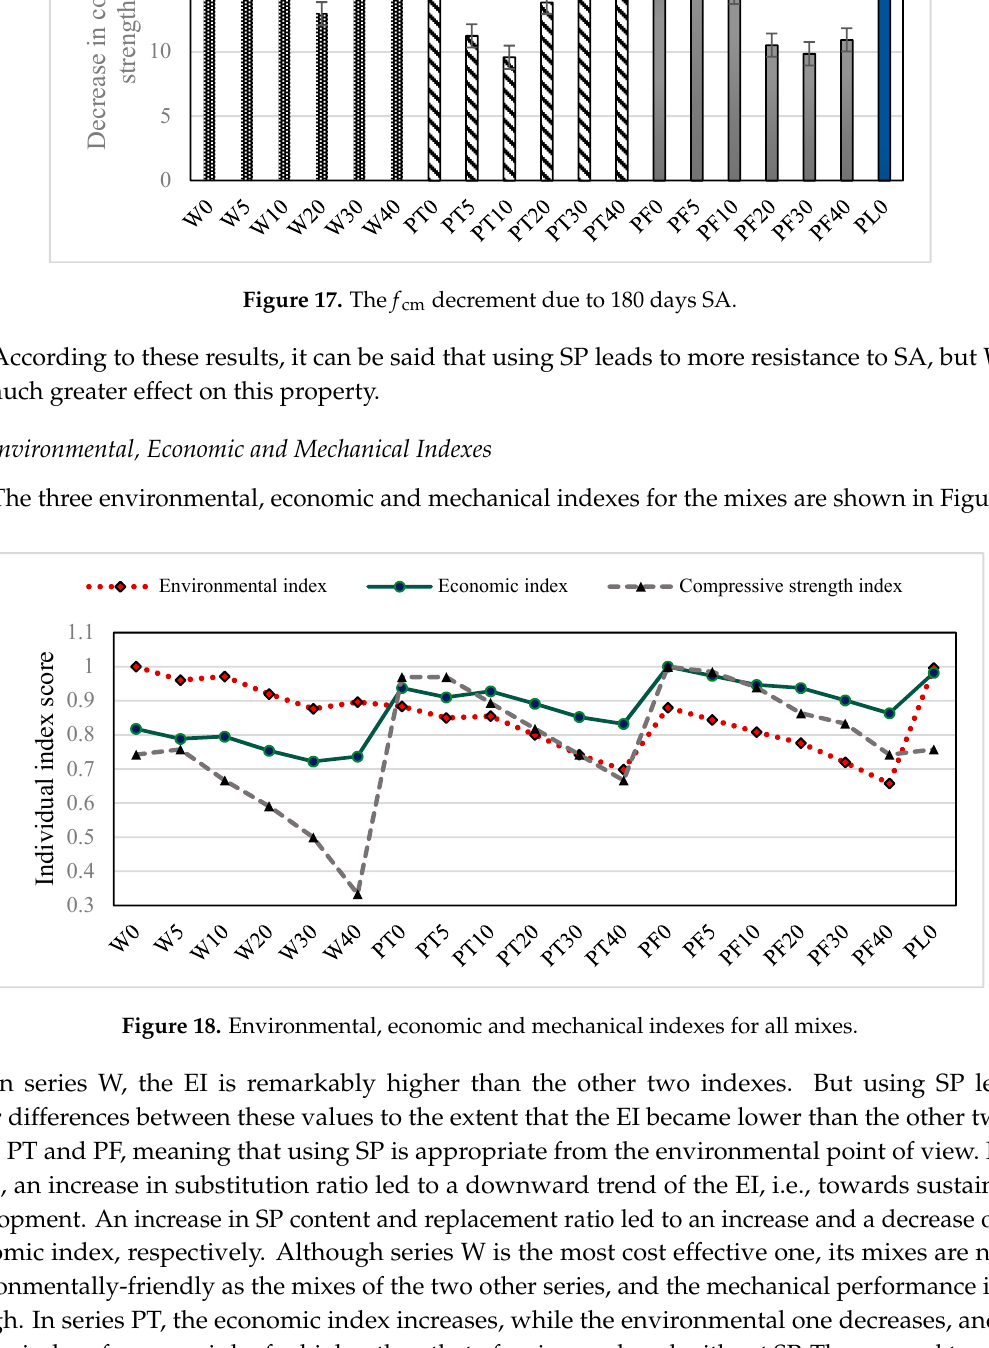
Figure 17. The f cm decrement due to 180 days SA.